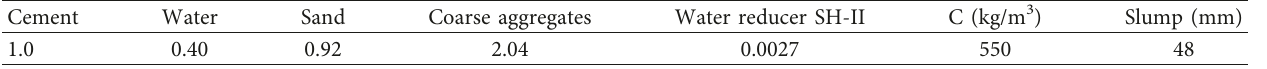
Table 1: Mixing ratio of benchmark concrete.